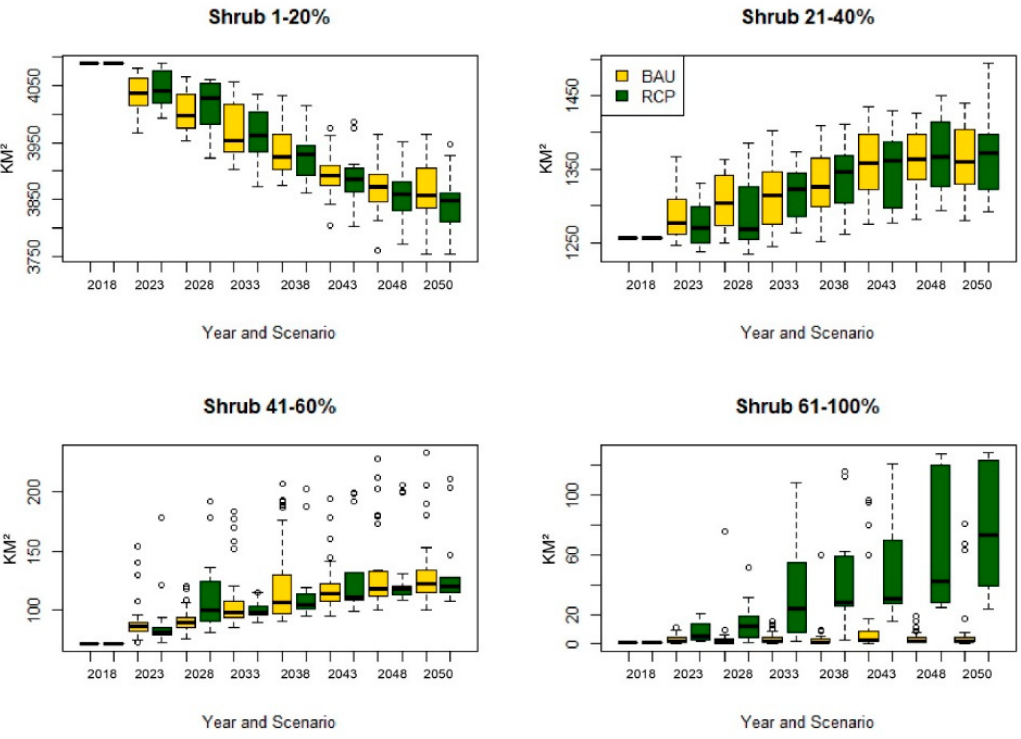
Figure 3. Business as Usual (BAU) and Representative Concentrations Pathway (RCP) 8.5 scenario results for shrub cover (km 2 ), summarized across the entire study area. Variance and mean were calculated from across the 30 model runs. Data from 2018 have no error bars as they were observed directly using Back in Time (BIT) data. The y -axis varies between plots.